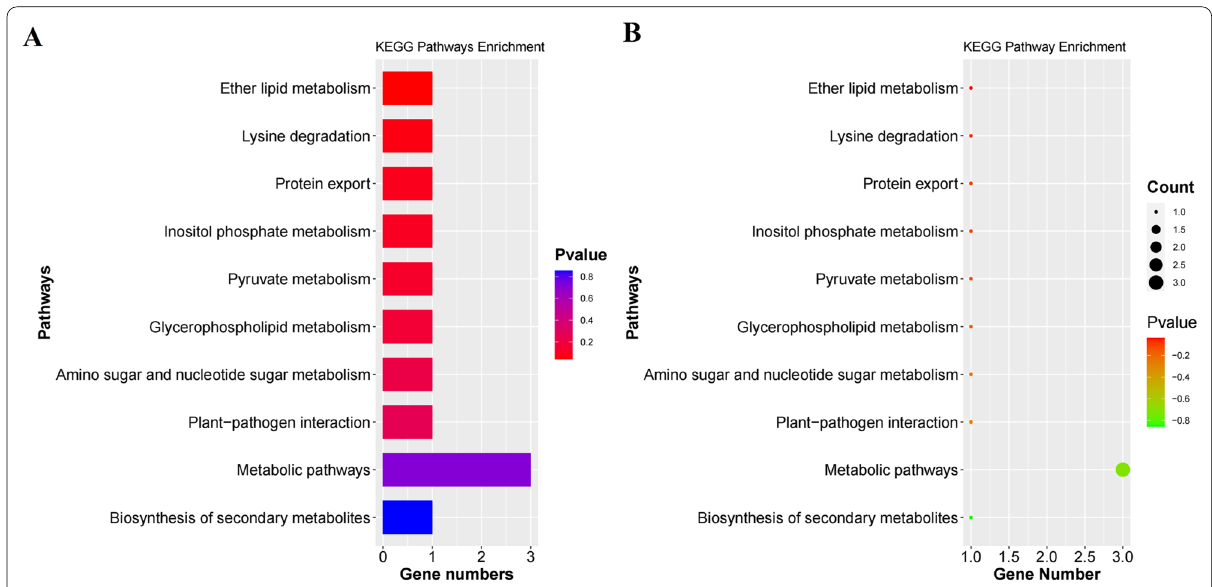
Fig. 3 KEGG functional classification and biological pathway enrichment of 58 genes